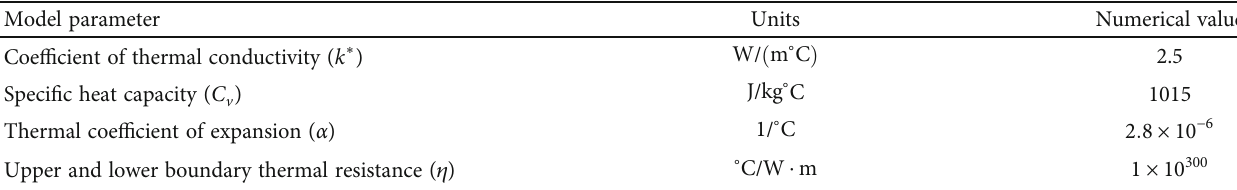
Table 2: Microstructure parameters of PFC 2D thermal model.